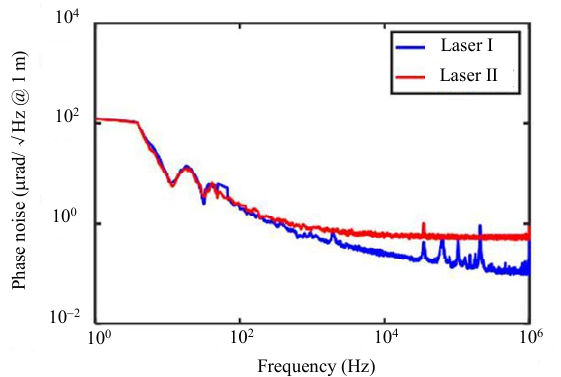
Fig. 2 Measurements of the phase noise PSDs of Laser I with the linewidth of 0.1 kHz and Laser II with the linewidth of 2.2